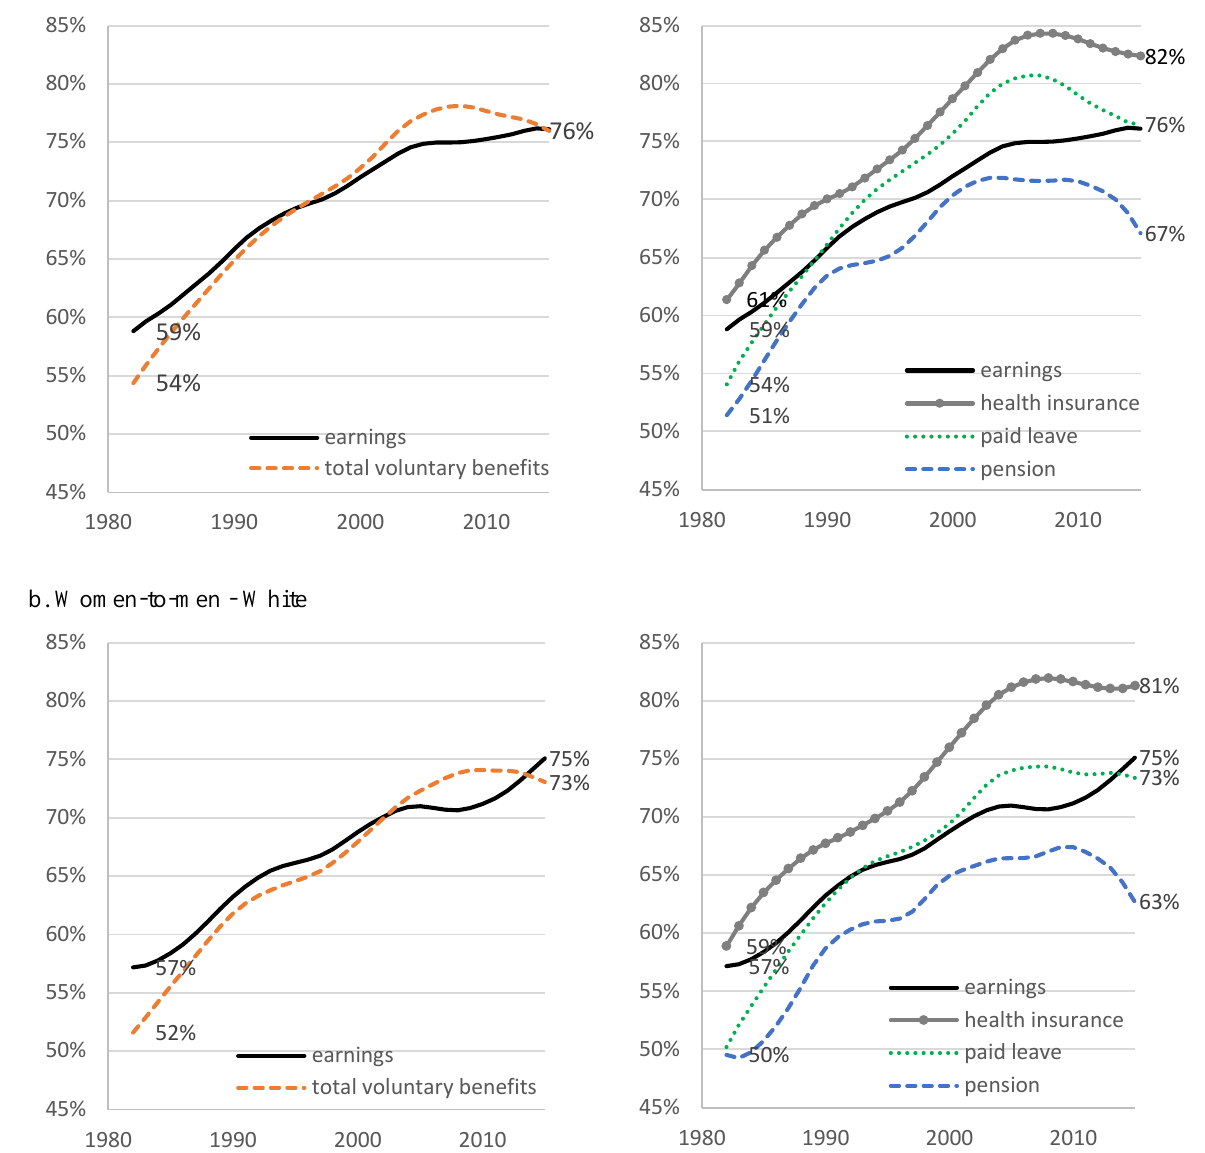
Figure 4: Women-to-men weekly health insurance, pension, paid leave, and total voluntary benefits